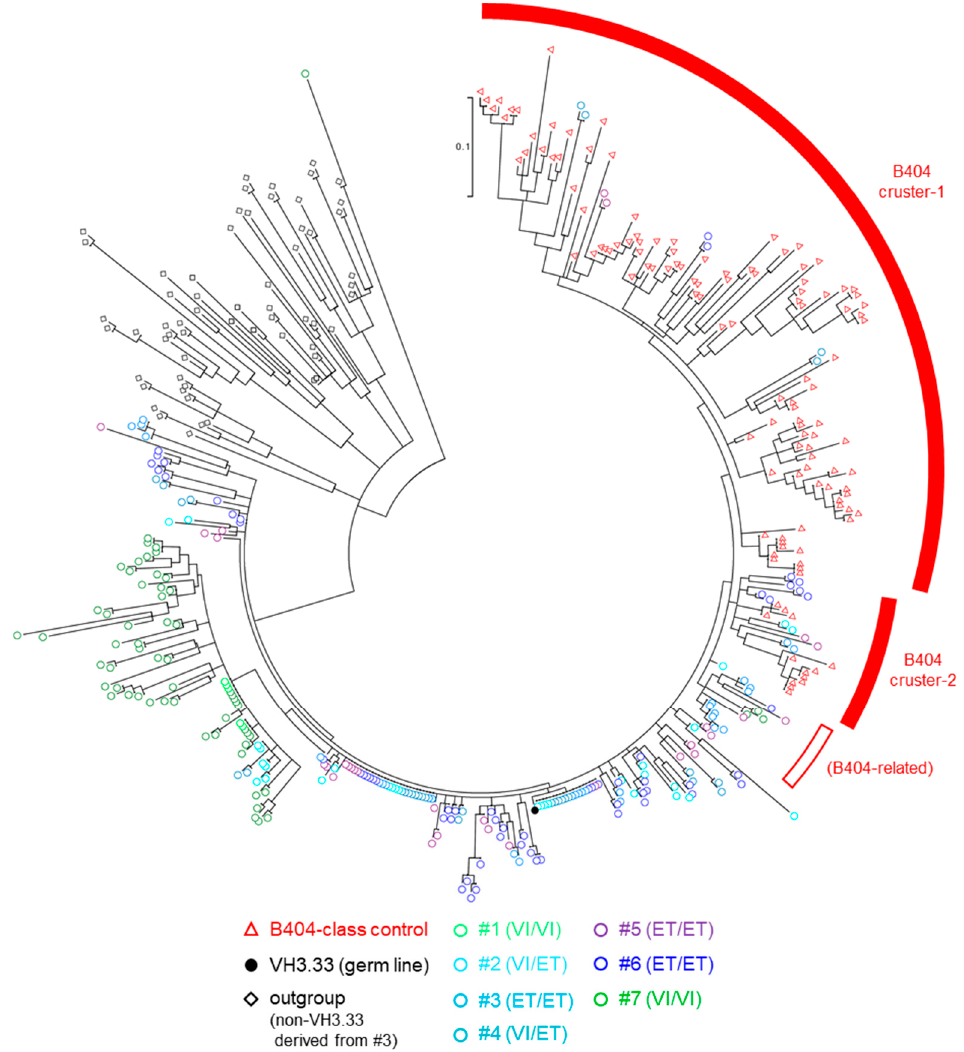
Figure 3. Phylogenic analysis of BCR-VH3.33 cDNA. NGS analysis of IgG VH genes. PBMCs at month 24 of all macaques and LNs at month 24 of macaques #2 and #6 were used. BCR VH regions were amplified from these sample-derived RNAs using a VH3-specific forward primer and an IgG constant region-specific reverse primer. The top thirty large sequences in terms of the read counts, which were determined as VH3.33 by IgBLAST, in individual samples (circles) are subjected to phylogenetic analysis, except for macaque #1 PBMC-derived samples, in which only five subjected were used due to the limitation of obtained sequence read counts. A total of 124 B404-class VH controls obtained in our previous study (red triangles) [16] and 60 non-VH3.33 sequences derived from #3 (black diamonds) were added as controls.